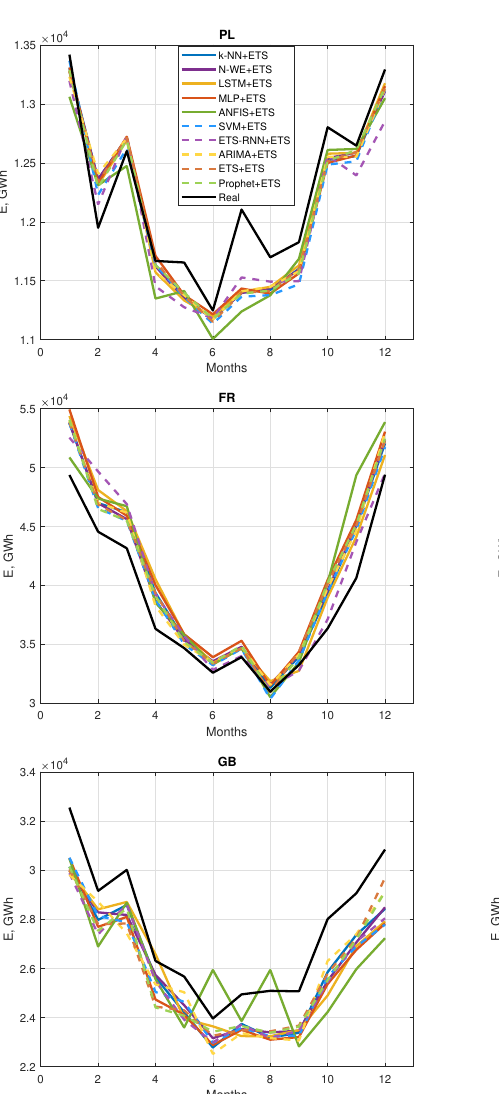
Figure 11. MAPE for each month.